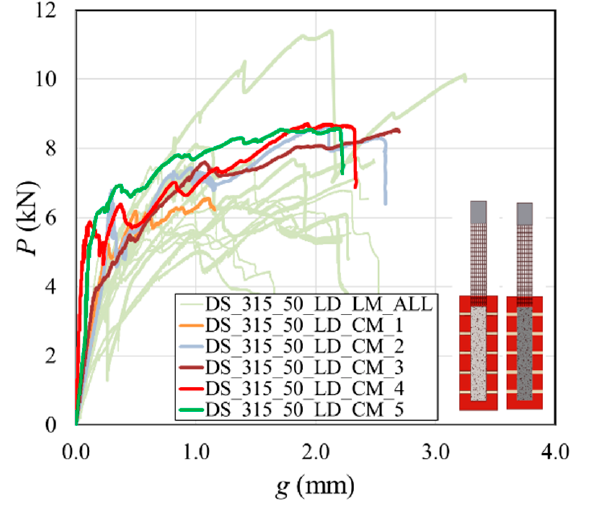
Figure 7. Comparison of load responses of SRG-masonry joints strengthened with two types of matrix.